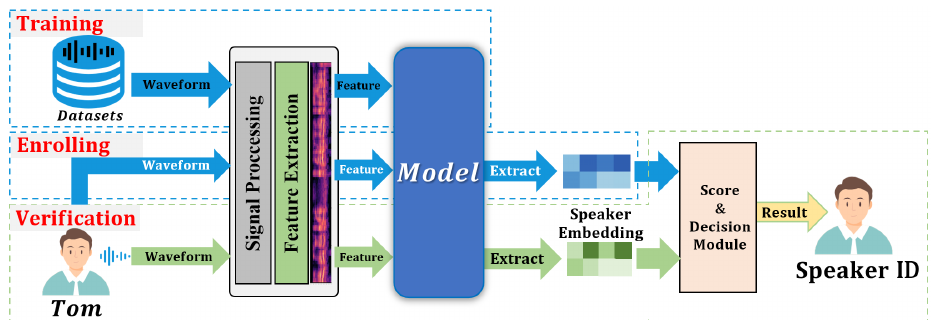
Figure 1. General framework of the speaker recognition